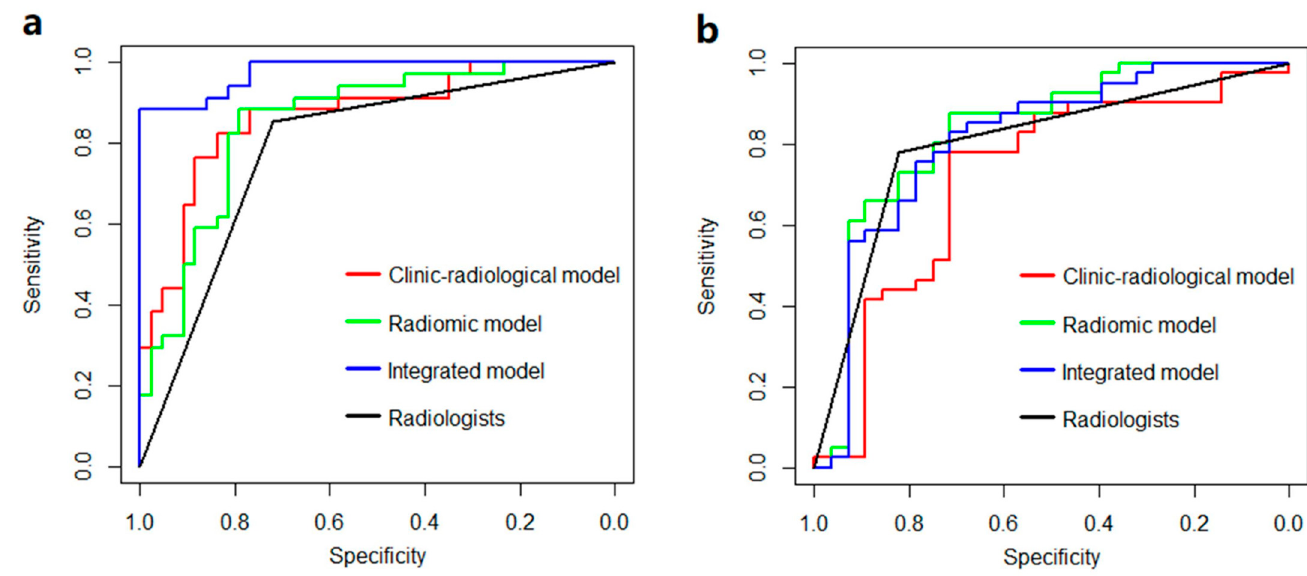
Figure 2. The ROC curve of models and radiologists. ( a ) training set, ( b ) external test set. The diagnostic performance of the clinico-radiological model is presented in Table